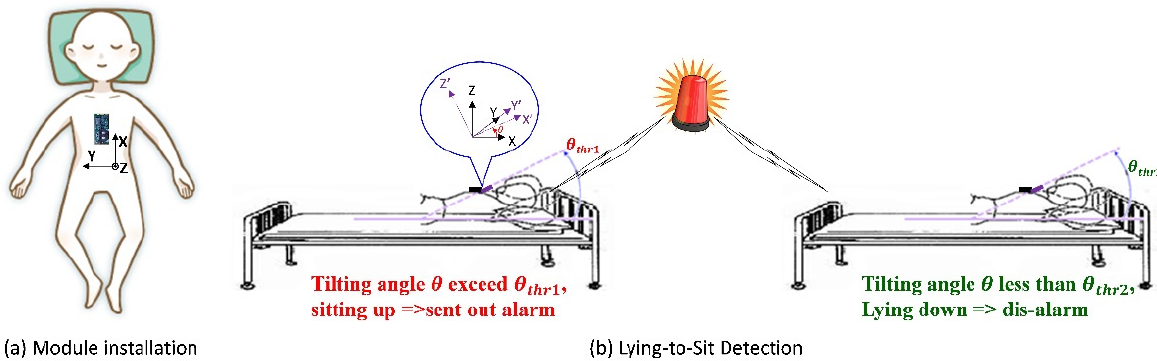
Figure 8. ( a ) BASIC module installation. ( b ) Detection of posture change (from lying down to sitting up) and alarm.